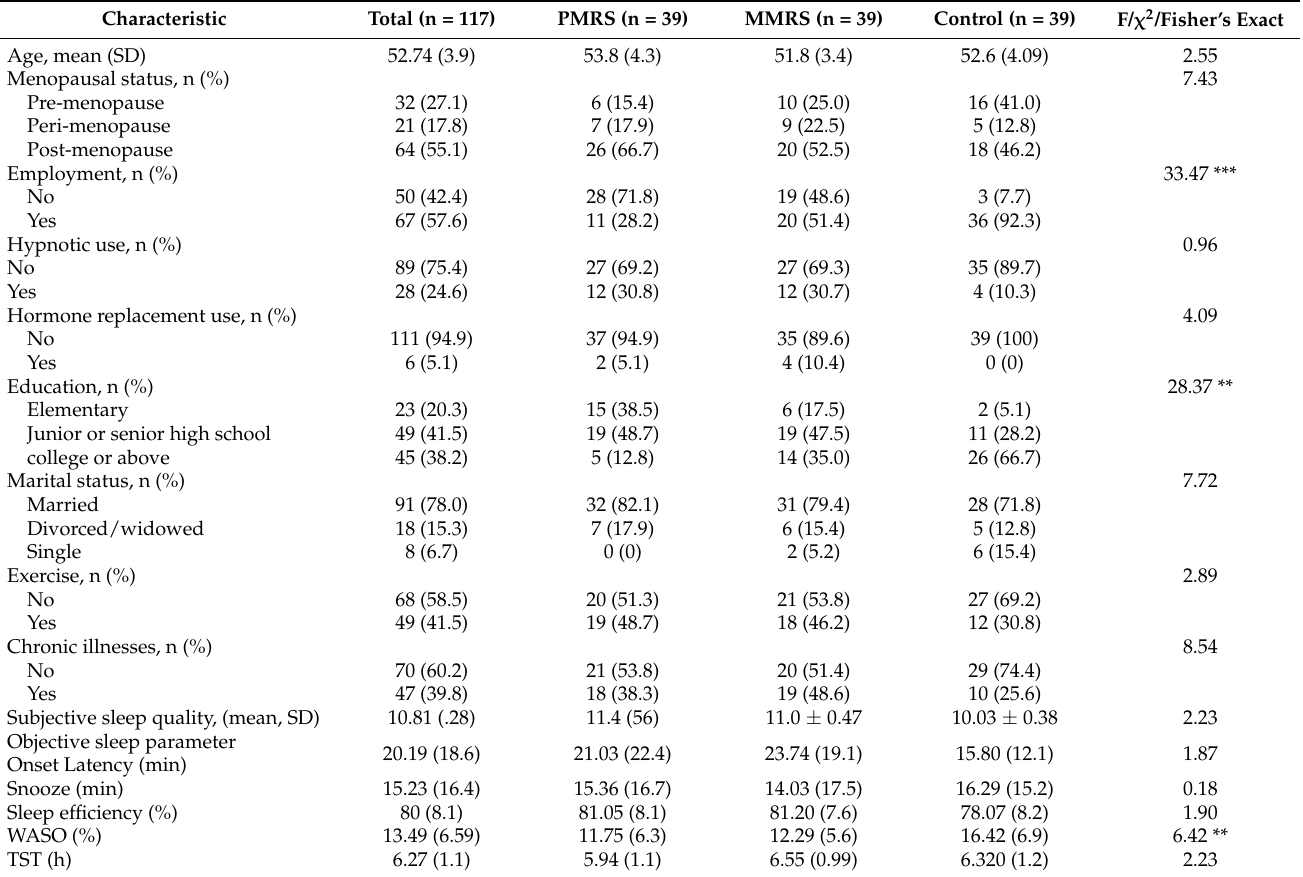
Table 2. Demographic characteristics at